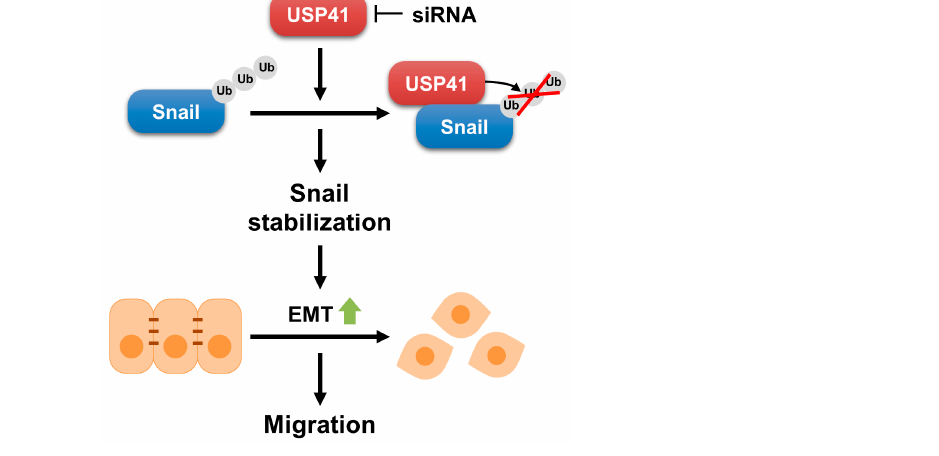
Figure 7. Schematic illustration showing the role and mechanism of USP41 in Snail stabilization and EMT.